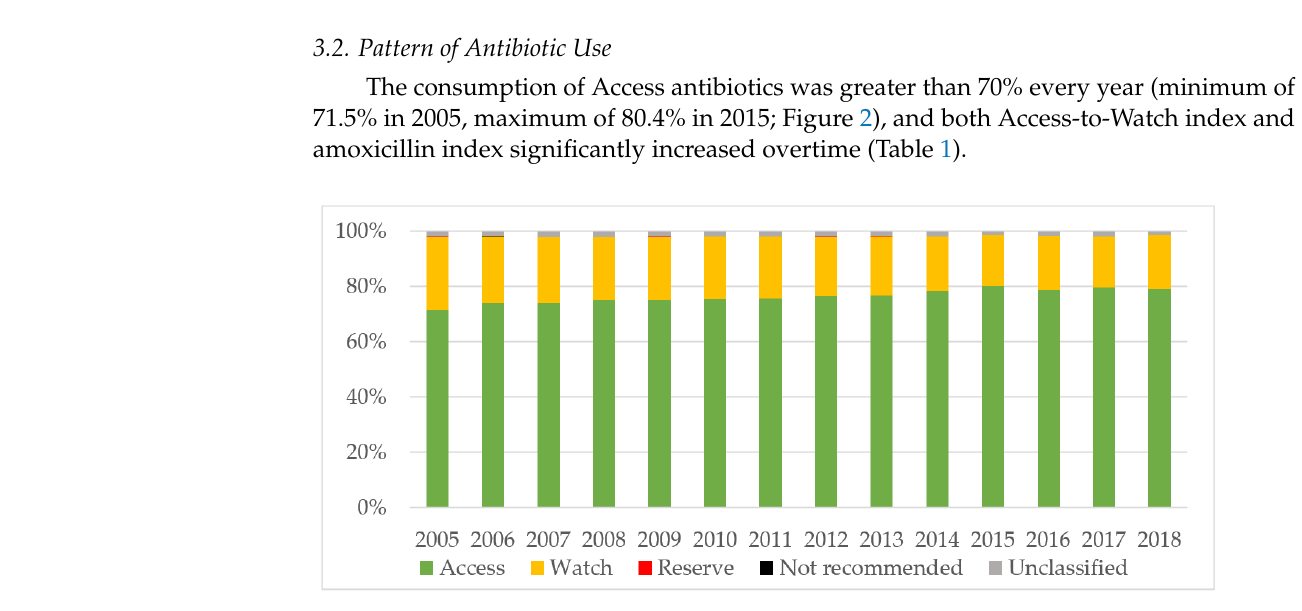
Figure 2. Consumption of antibiotics (%) according to the AWaRe classification in pediatric outpa- tients in Asturias (2005–2018). AWaRe: Access, Watch, and Reserve antibiotics.